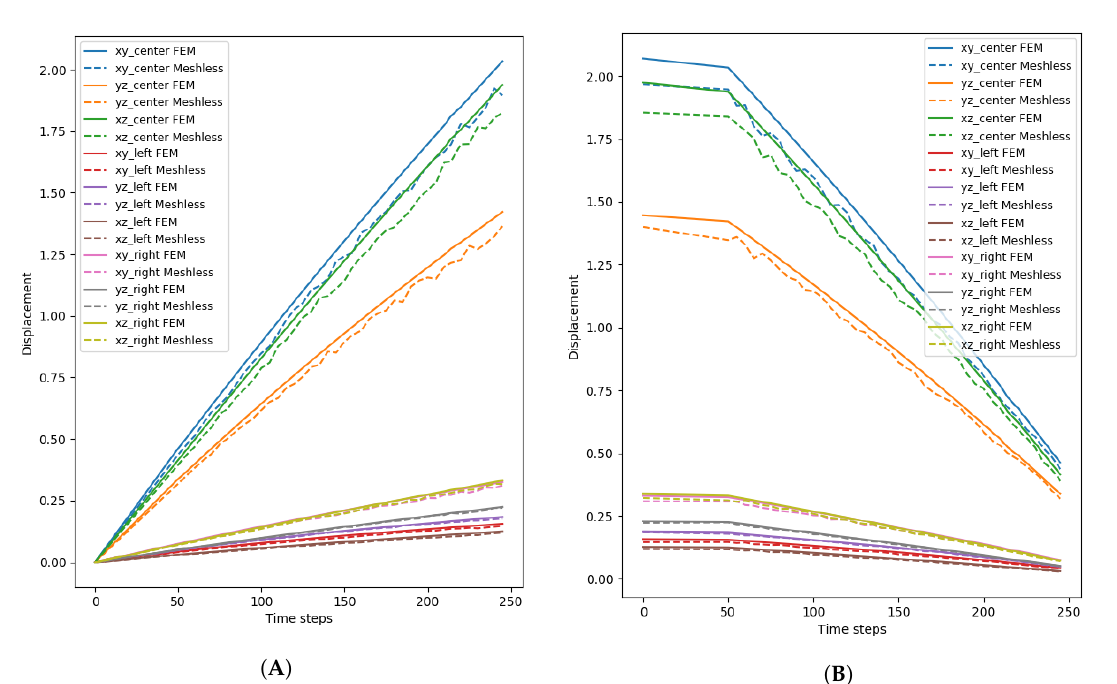
Figure 10. Mean displacement of the triceps. ( A ) shows the mean displacement for the contraction step, ( B ) shows the mean displacement for the expansion step.